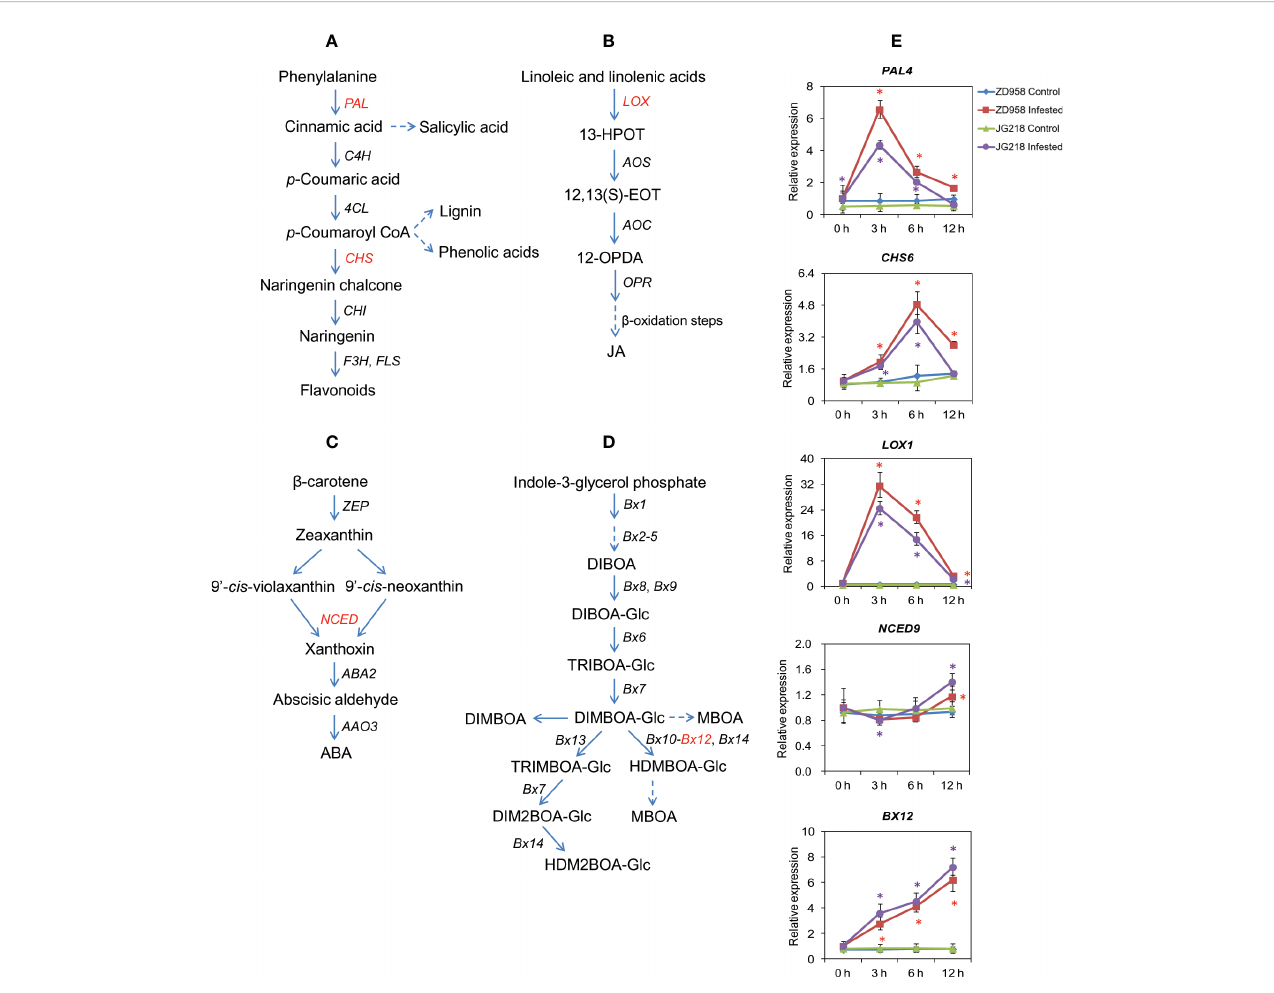
FIGURE 9 Effect of S. frugiperda infestation on phytohormones and secondary metabolite-related gene expression in maize leaves. (A) Biosynthetic pathway of fl avonoids and salicylates. (B) Biosynthetic pathway of jasmonic acid. (C) Biosynthetic pathway of abscisic acid. (D) Biosynthetic pathway of benzoxazinoid. (E) qRT-PCR analysis of phytohormones and secondary metabolite-related genes. Data are shown as means ± SD ( n = 3, every n represents the mean of three seedlings). Signi fi cant differences at P < 0.05 between the control and S. frugiperda -infested groups are indicated with an asterisk. The red asterisk represents signi fi cant differences for ZD958 and the purple asterisk for